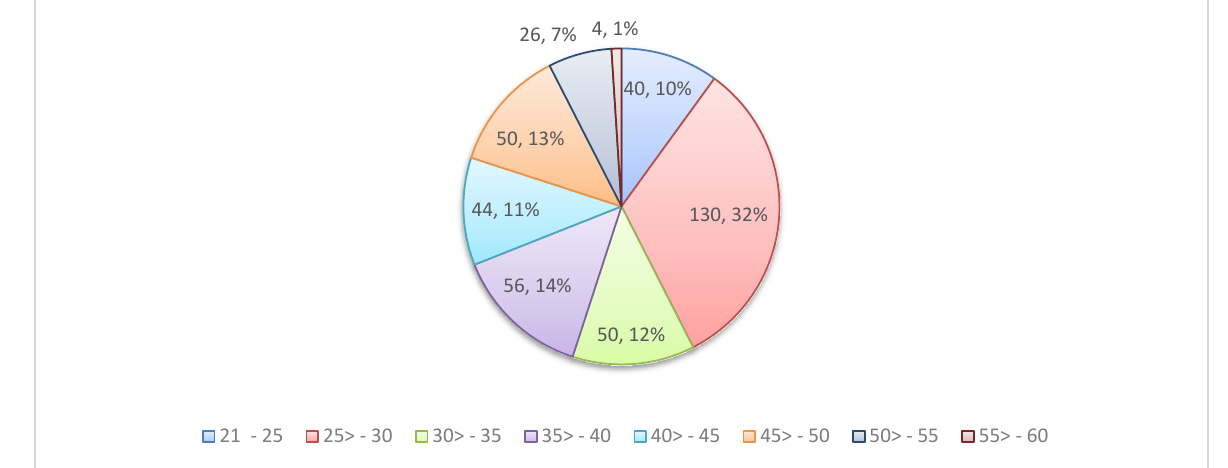
Fig. 2. Description of Respondents by Age